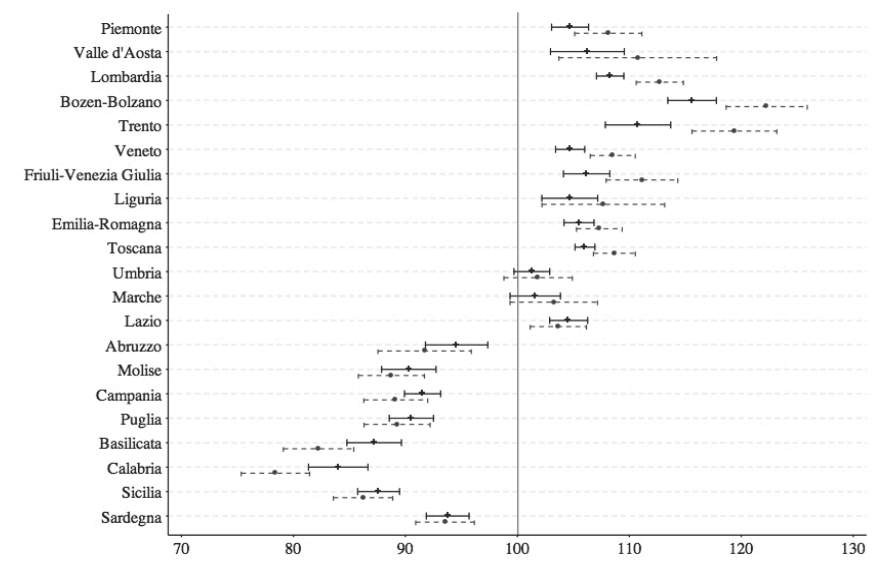
Figure 2 – Inequality adjusted multidimensional well-being comparisons Note: each bar indicates the 95% confidence interval for the welfare measures (normalized so that Italy=100) implied by the Tsui inequality indices with  =1 (continuous line) and  =2.5 (dotted line). Source: authors’ elaboration on 2008 IT-SILC